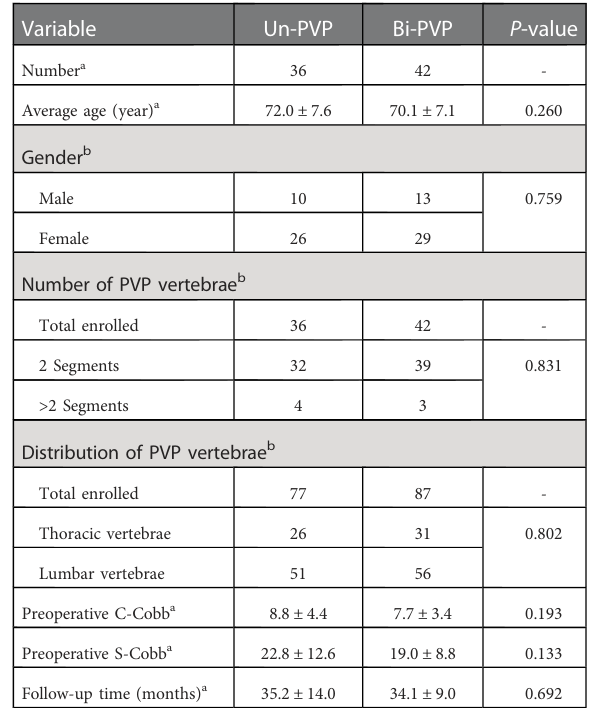
TABLE 1 Preoperative demographic